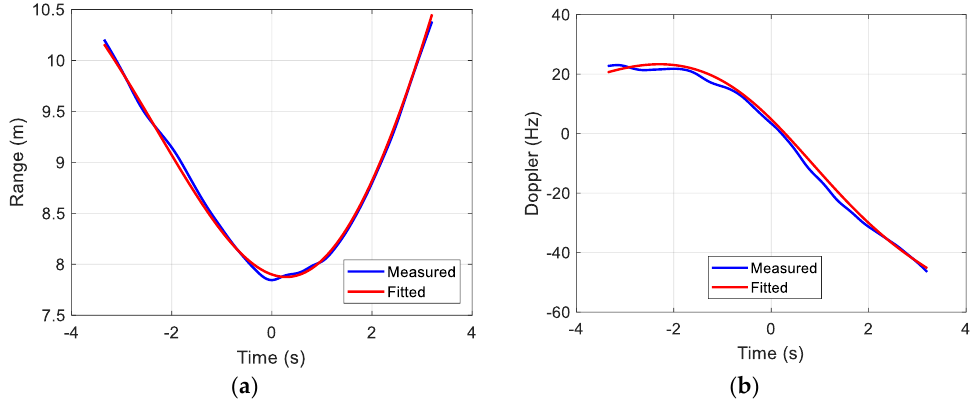
Figure 8. Drone in-flight range/Doppler curve fitting. ( a ) Range vs. time; ( b ) Doppler vs. time.